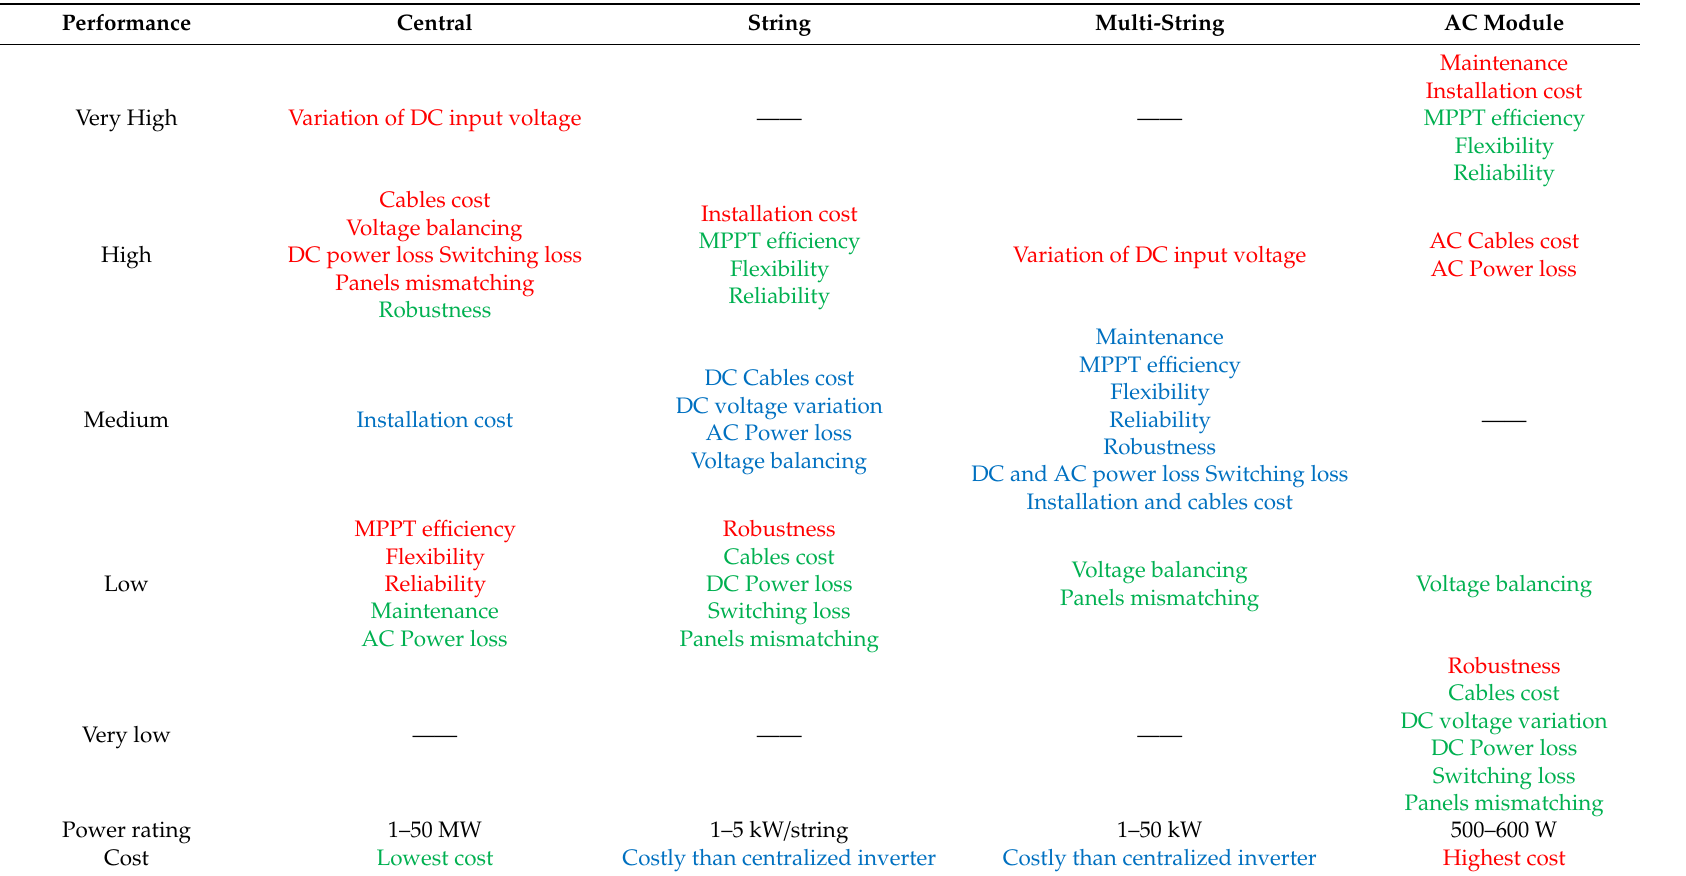
Table 2. Performance Evaluation of PV inverters